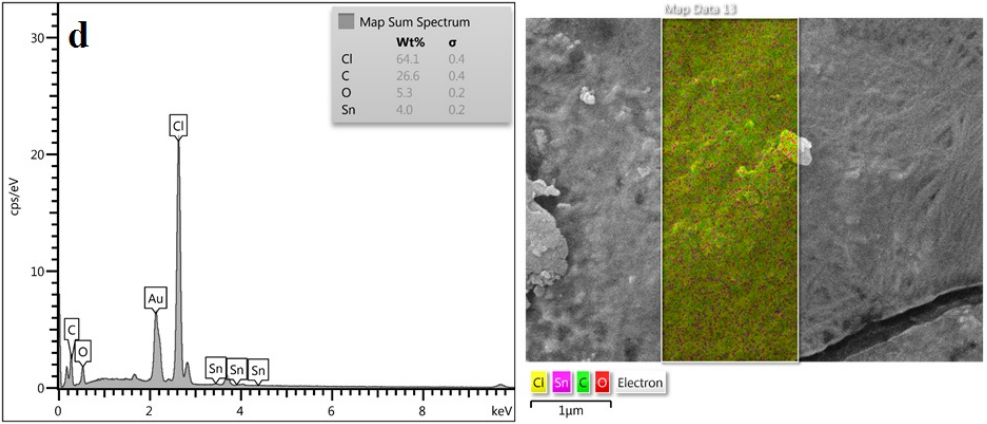
Figure 6. EDX mapping graphs of ( a ) PVC ( b ) PVC + 1 ( c ) PVC + 2 and ( d ) PVC + 3 after exposure to UV light.